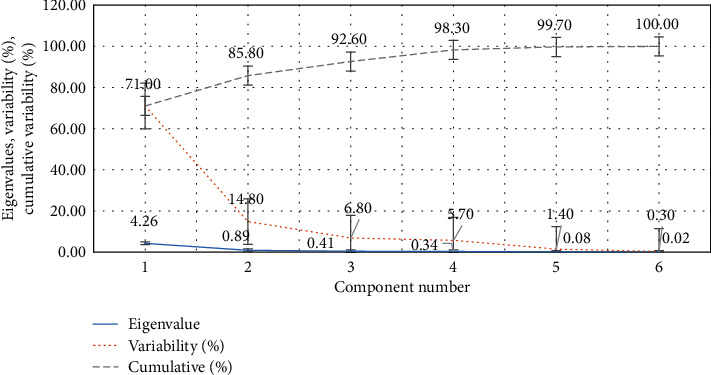
Scree plot in PCA analysis for eigenvalues, variability (%), and cumulative variability (%).